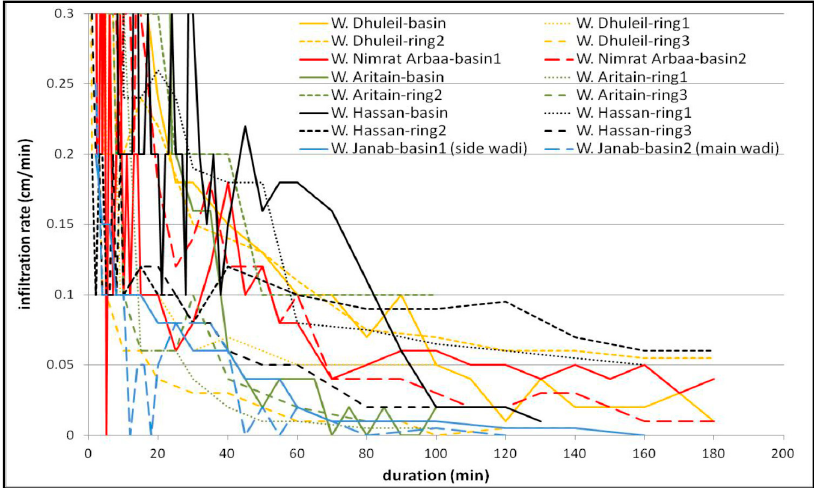
Figure 5. Development of the infiltration rate (cm/min) during the test duration based on Reference [23].